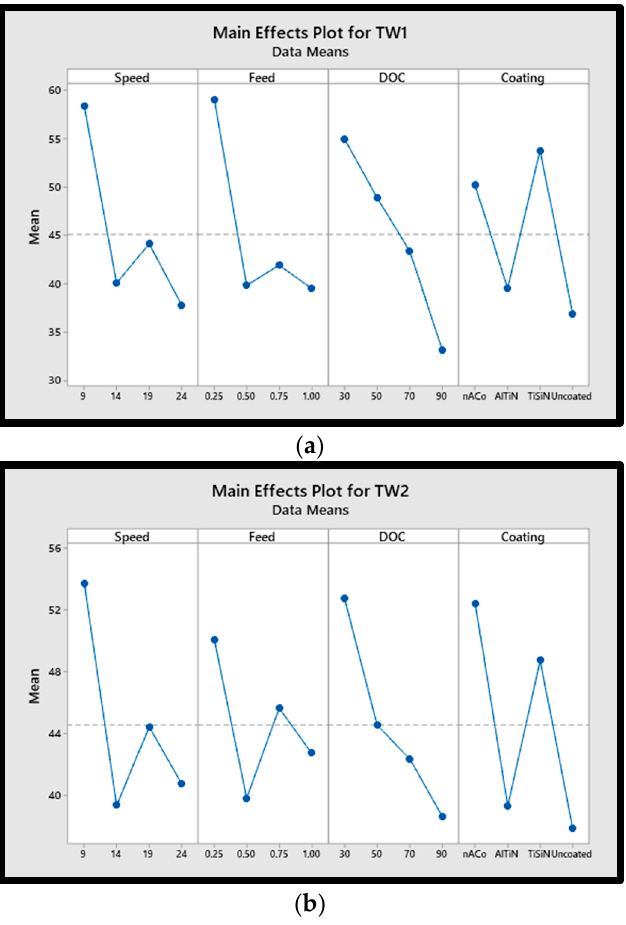
Figure 3. Main effects plot of tool wear ( a ) flute 1, ( b ) flute 2.